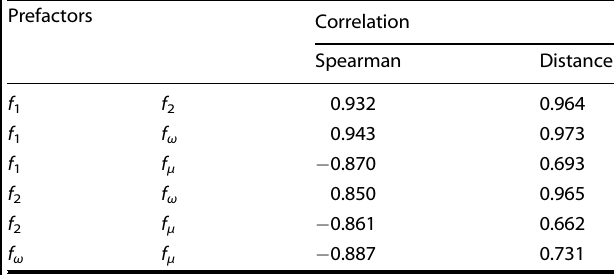
Table 2. Correlations between Allen – Dynes and machine-learned